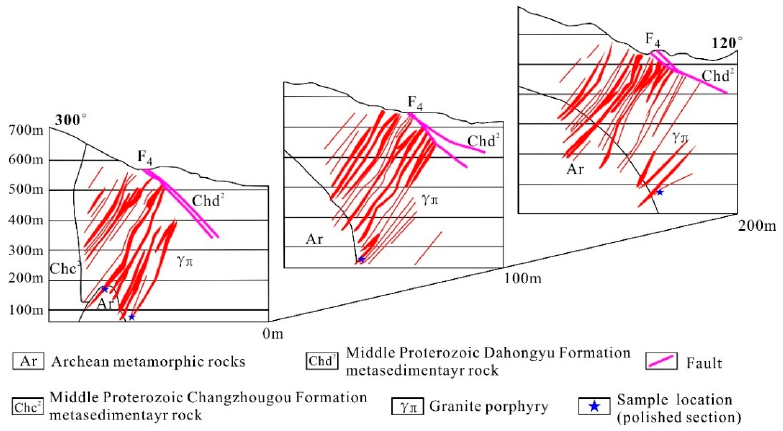
Figure 3. Joint section map of the Line 15–Line11–Line 7 ore bodies (From left to right) of the Xiajinbao gold deposit.